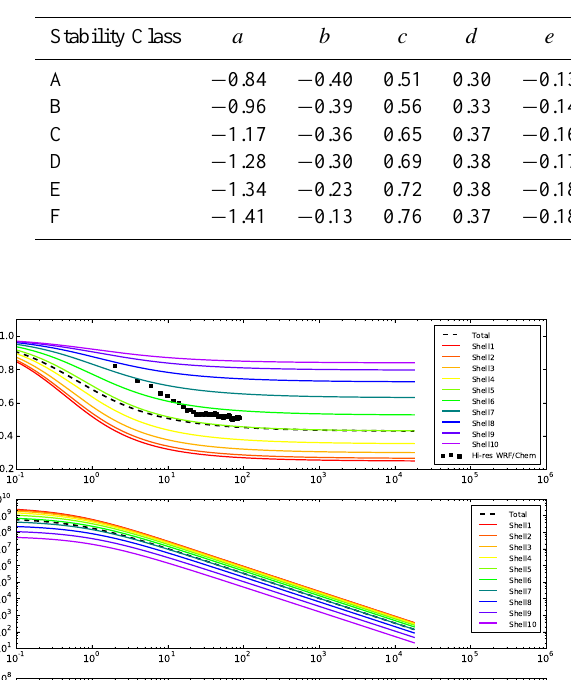
Table 2. The fitted exponents and constant corresponding to Eq. (5) for each stability class as well as the root-mean-square error and correlation coefficient in the fraction of particles remaining associated with each fit. The exponents a , b , c , d , and e correspond to the parameters v w , R s , P , σ , and D p , respectively. Stability classes: A, extremely unstable; B, moderately unstable; C, slightly unstable; D, neutral; E, slightly stable; and F, moderately stable.